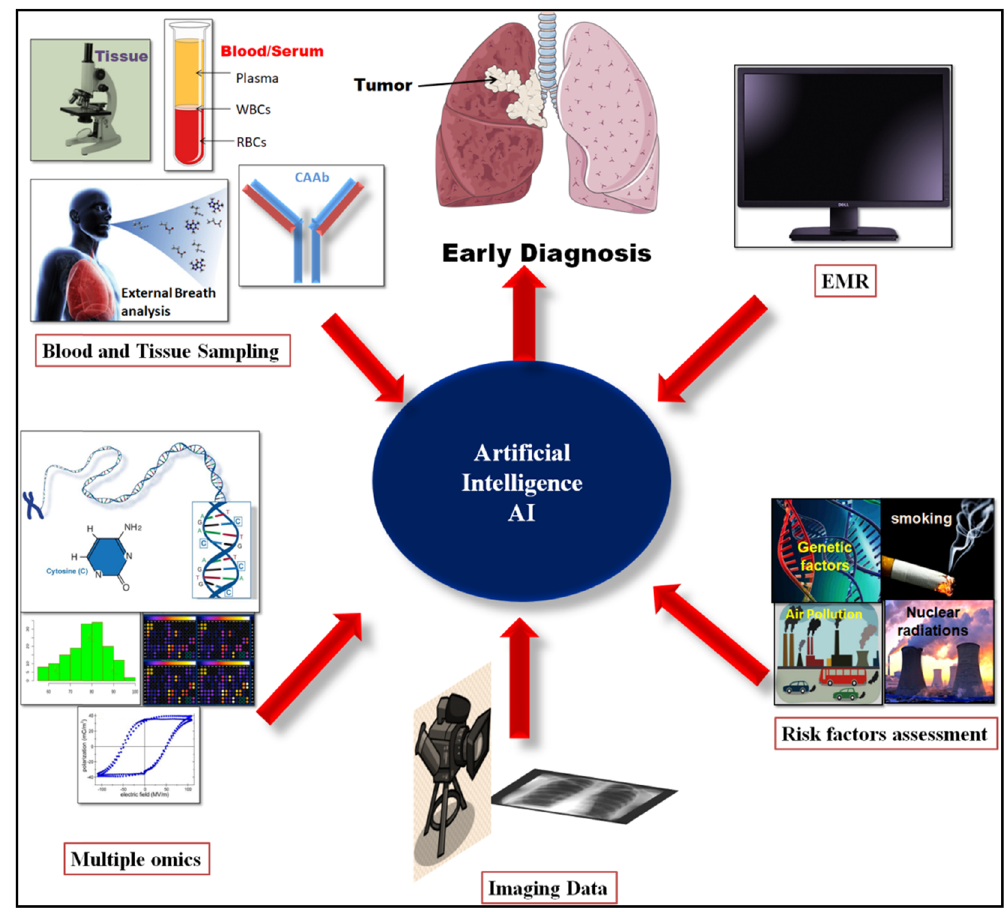
Figure 9: AI algorithms have the ability to enhance the early detection of LC by combining numerous data sources [ 13 ]